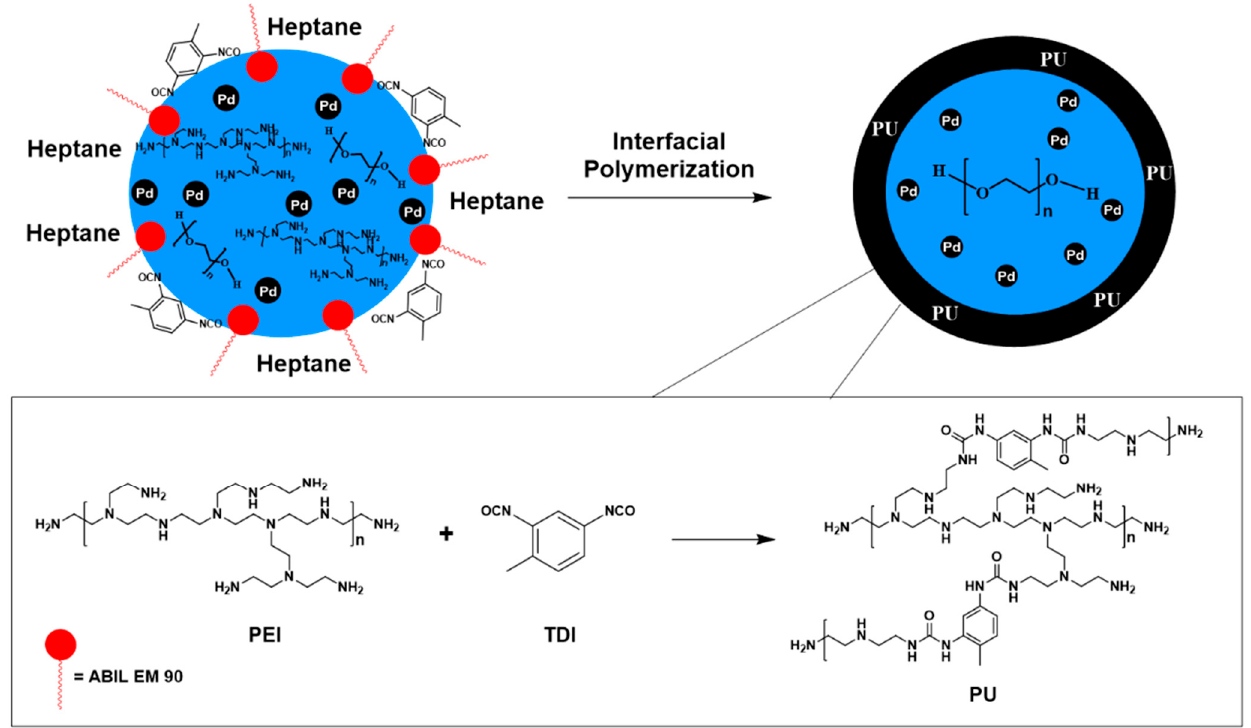
Scheme 1. Schematic illustration of the Pd NPs /PEG 200 @PU preparation